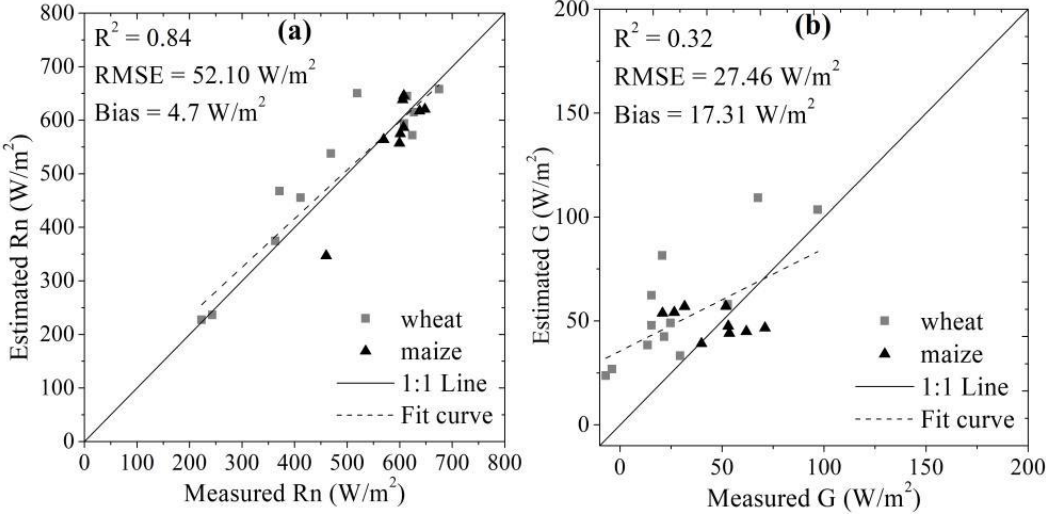
Figure 4. Validation of the measured and estimated Rn ( a ) and G ( b ) at the Guantao site. Figure 5 shows the comparisons of estimated and measured instantaneous LE for the three models. The correlations for estimated versus observed instantaneous LE values were di ff erent, with R 2